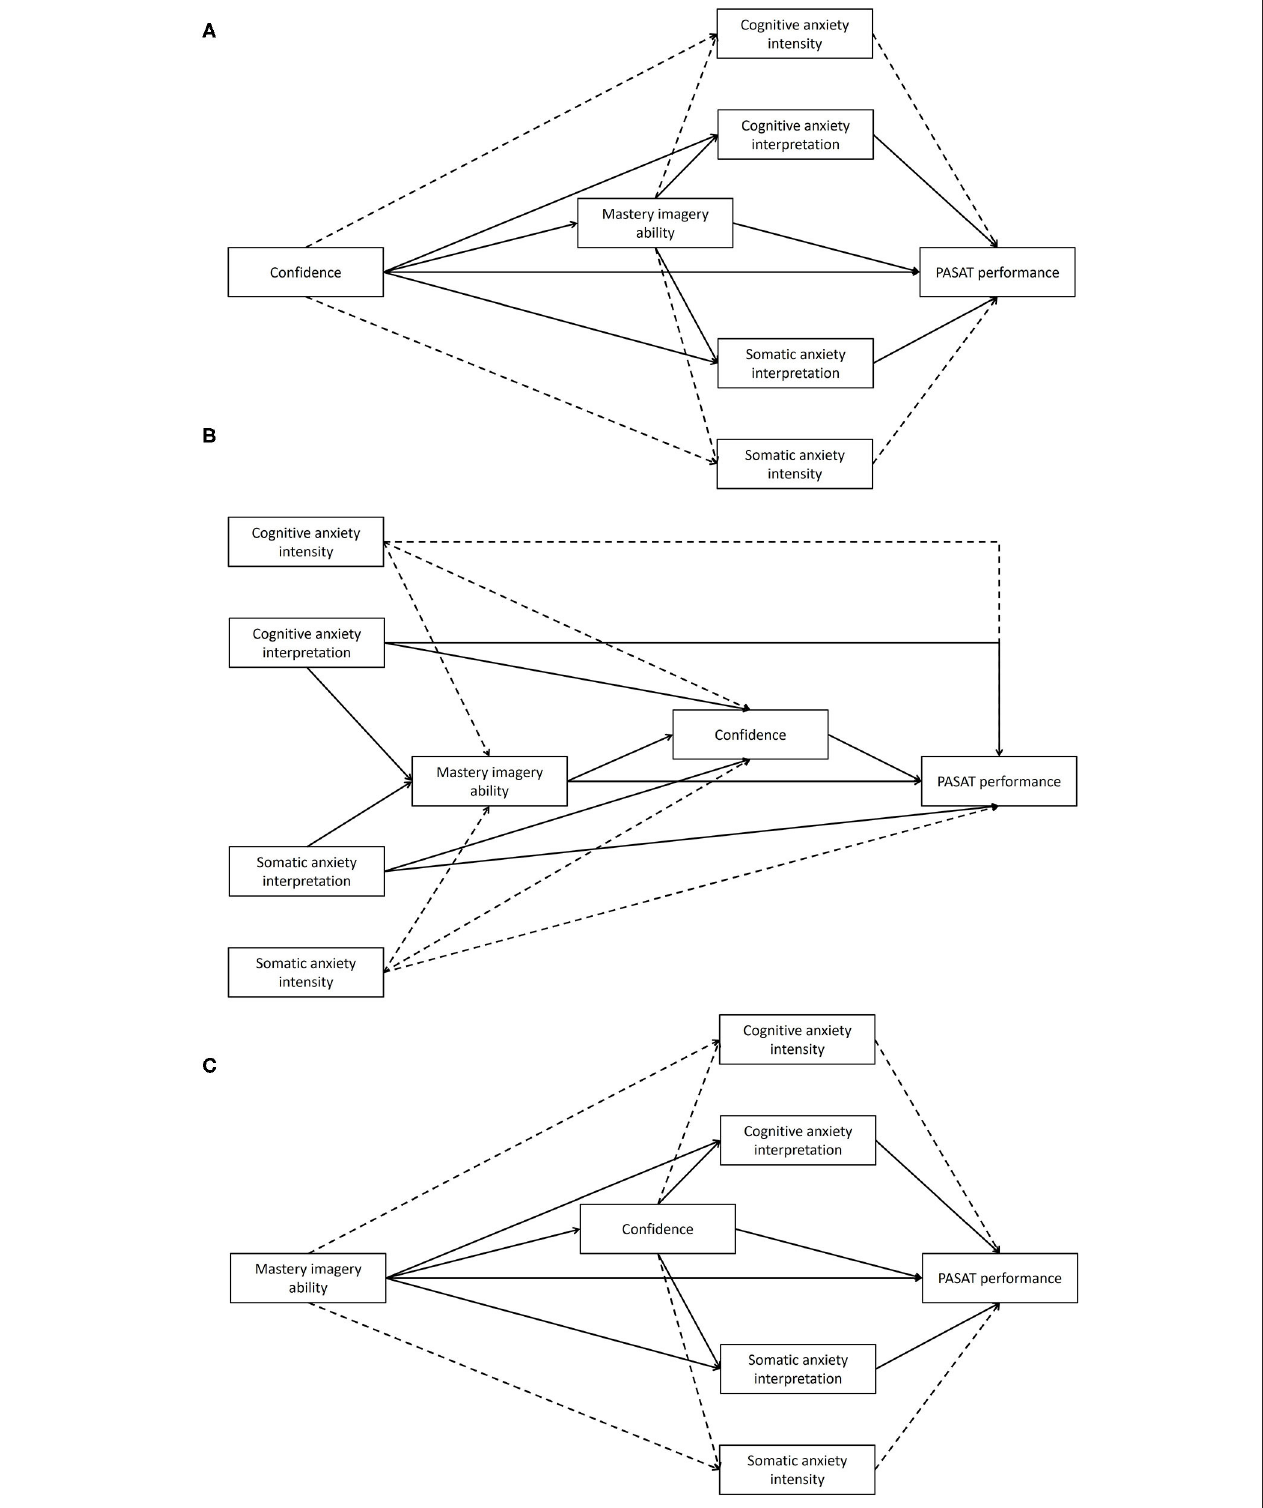
FIGURE 1 | (A) Hypothesized model, (B) Alternate model 1, (C) Alternate model 2. For visual simplicity, controlling variable gender is not presented but was included in the analyses. Full lines represent positive regressions, dashed lines represent negative regressions.